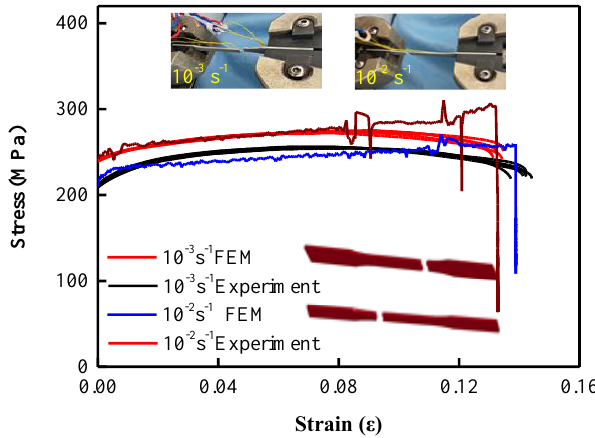
Figure 4. True stress – strain curves of AlSi10Mg specimens at different strain rates.